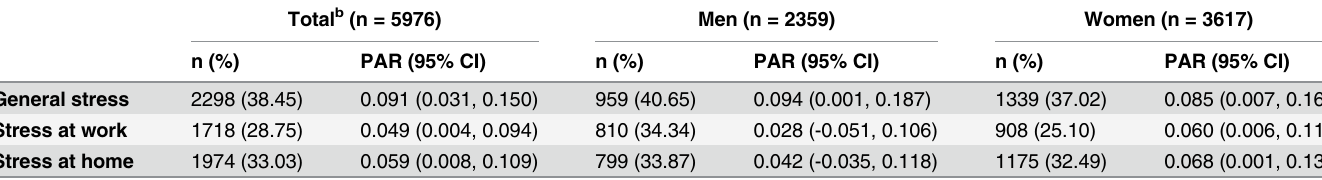
Table 5. Population-attributable risk of hypertension by different types of stress and gender based on logistic regression a